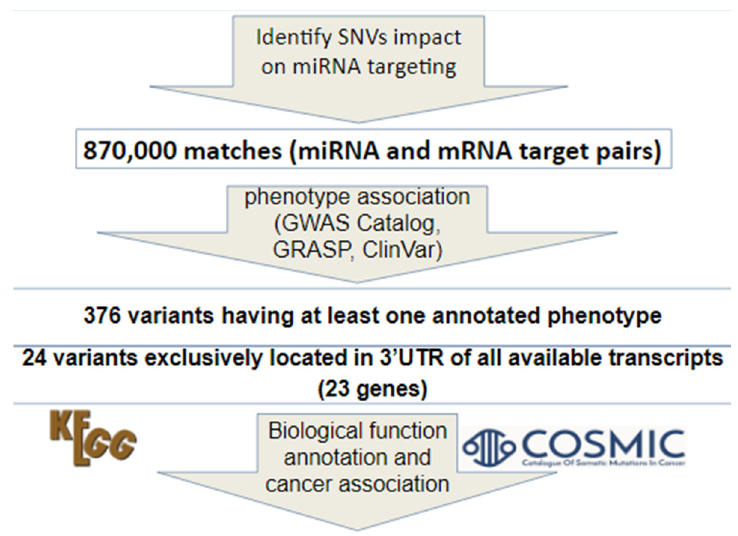
Figure 1. Pipeline for identifying single nucleotide variants (SNVs) using dbMTS and cancer pathway databases.